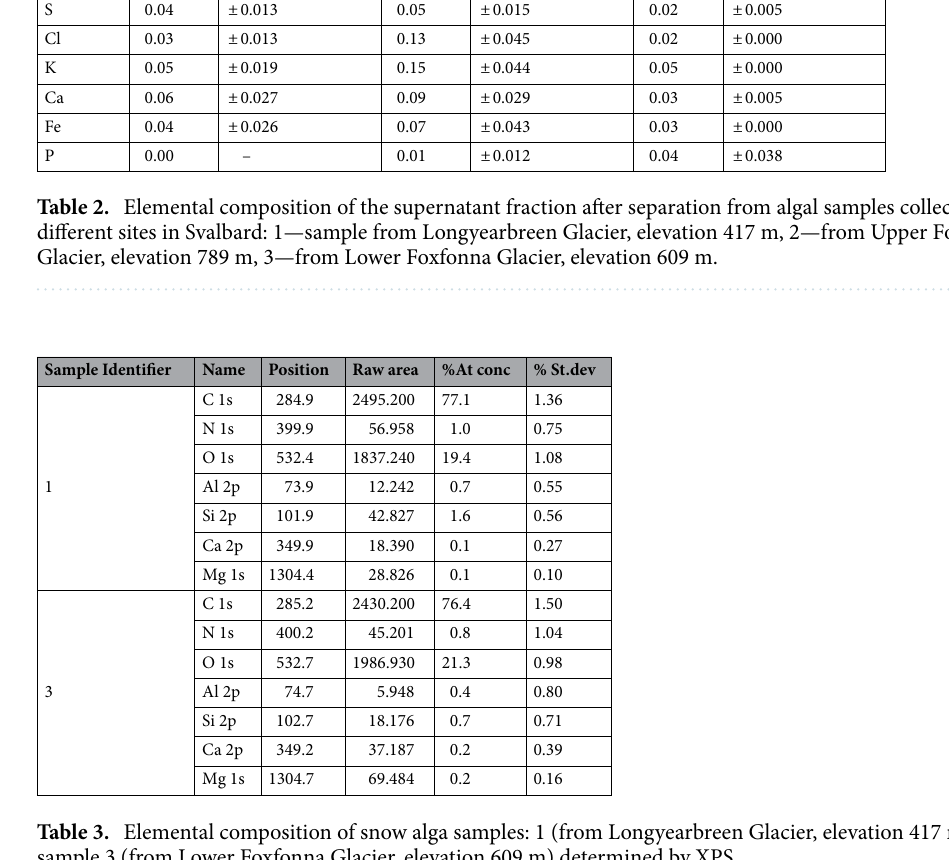
Table 3. Elemental composition of snow alga samples: 1 (from Longyearbreen Glacier, elevation 417 m) and sample 3 (from Lower Foxfonna Glacier, elevation 609 m) determined by XPS.